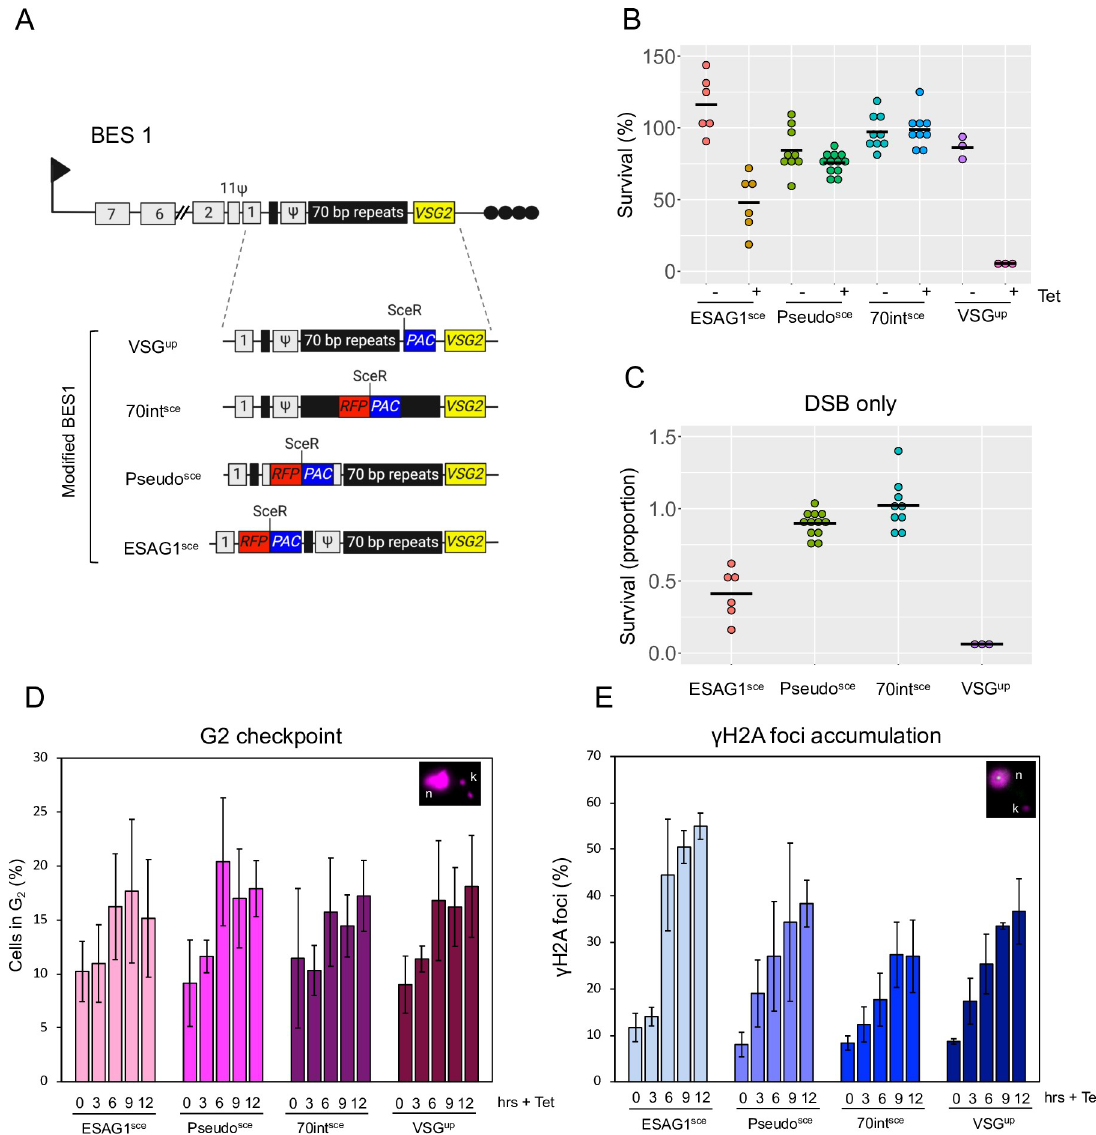
Fig 1. Double strand breaks upstream of the active VSG are not typically lethal. (A) Schematic showing the VSG2 BES on chromosome 6a with the individual modifications. I-SceI recognition site (SceR) and reporter genes incorporated to give VSG up [37]; 70int sce ; Pseudo sce and ESAG1 sce . Arrow, BES RNA Pol1 promoter; grey boxes, ESAGS; black boxes, 70 bp repeats; yellow box, VSG; RFP : PAC , Red Fluorescent Protein and Puromycin N–Actyltransferase ; black circles, telomere. (B) Clonogenic survival assay, cells were plated out into 96 –well plates in either non or I-SceI inducing conditions. Clones were counted after 7 days. Centre lines indicate the medians. (C) Proportion of survivors following a I-SceI break. Number of replicate plates are as follows: VSG up , 3 plates per condition; 70int sce , 9 plates per condition; Pseudo sce , 9 plates for the–Tet and 12 plates for the + Tet and ESAG1 sce , 6 plates per condition. (D) Cell in G2 were determined by DAPI staining and scored according to the position of the nucleus (n) and kinetoplast (k) following an induction of an I-SceI break. n = 2 (independent inductions,) 100 cell counted for each time point by two independent researchers. (E) Focal accumulation of γ H2A as assessed by immunofluorescence assay following an induction of an I-SceI break. n = 2 (independent inductions,) 100 cell counted for each time point by two independent researchers. Error bars, SD. Individual biological clones were used for each cell line. VSG up served as a control